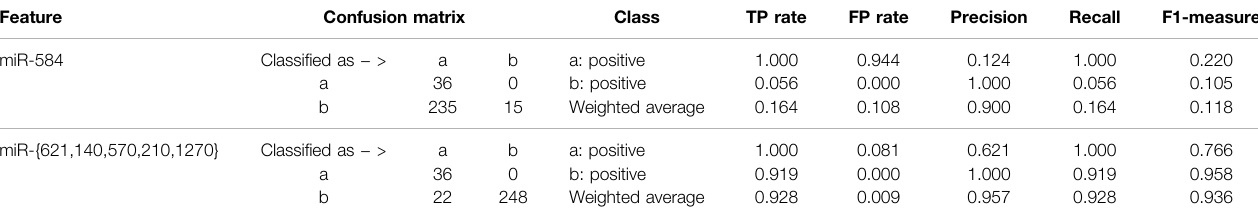
TABLE 2 | Quantitative results between the obtained fi ve-miRNA signature and the previously discovered miRNA (Liang et al., 2017). Feature Confusion